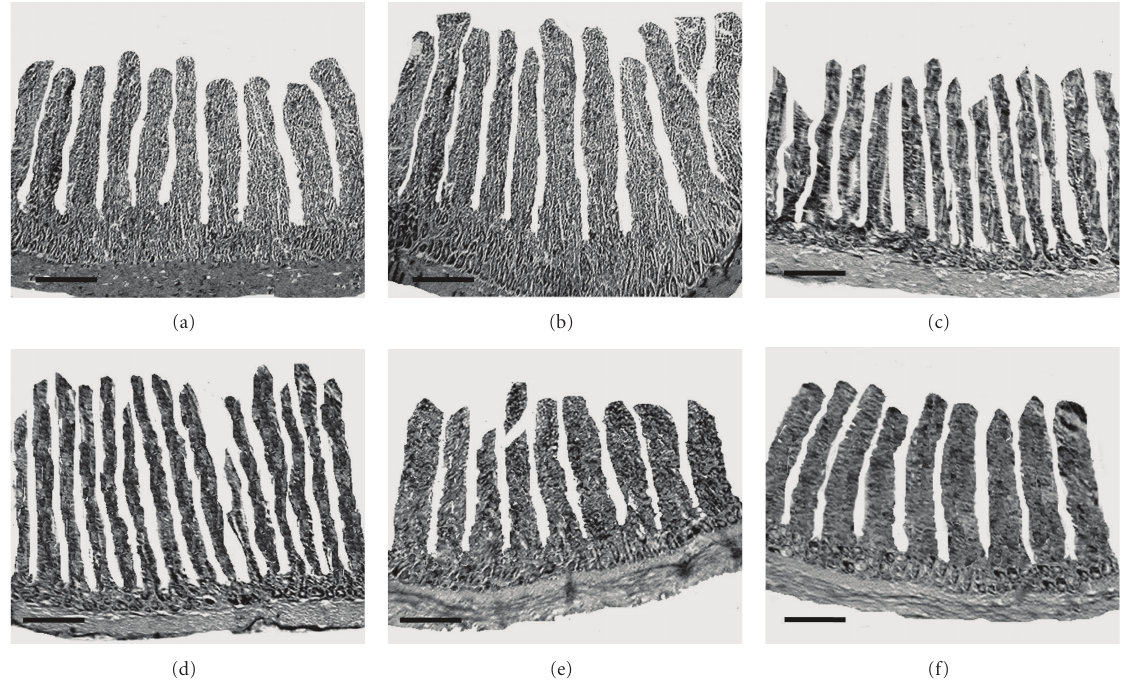
Figure 1: The sections of the duodenum, jejunum, and ileum showing villus height in control group and the birds supplemented with di ff erent organic acids. Hematoxylin and eosin staining. Scale bars represent 260 µ m.Villus height in the duodenum of broiler chicken in control group (a) and 3% butyric acid group (b). Villus height in the jejunum of broiler chicken in control group (c) and 3% fumaric acid group (d). Villus height in the ileum of broiler chicken in control group (e) and 2% fumaric acid group (f).